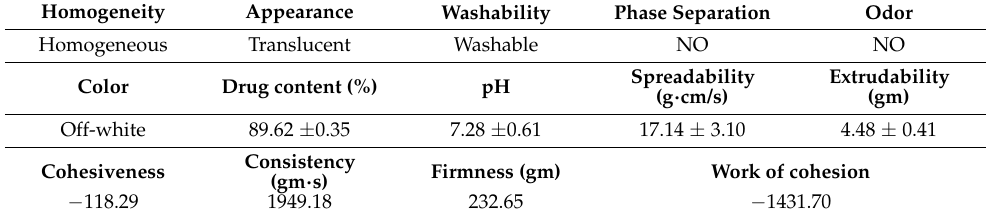
Table 2. Physiochemical characterization of HTC-based TES gel